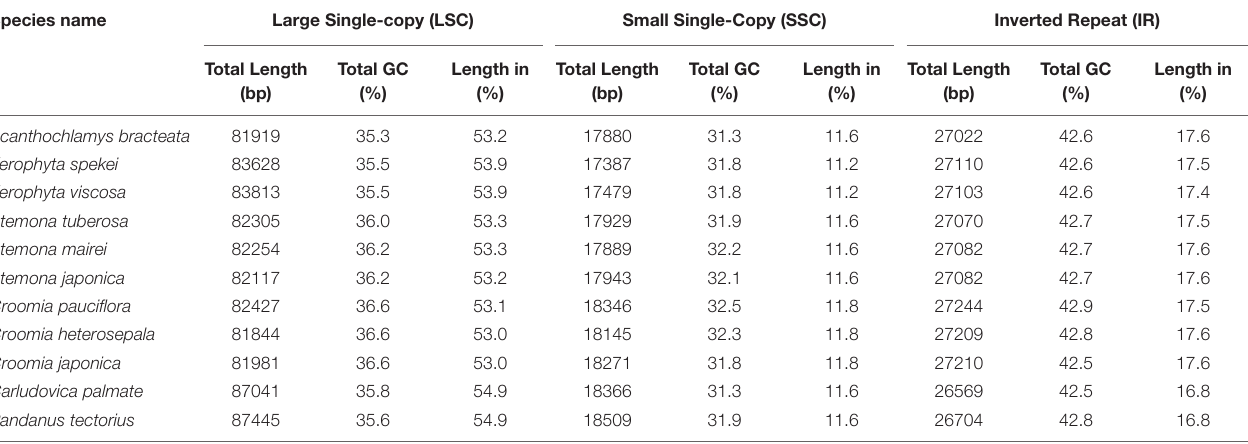
TABLE 2 | Features of the LSC, SSC and IR of the Order Pandanales’ Plastomes.